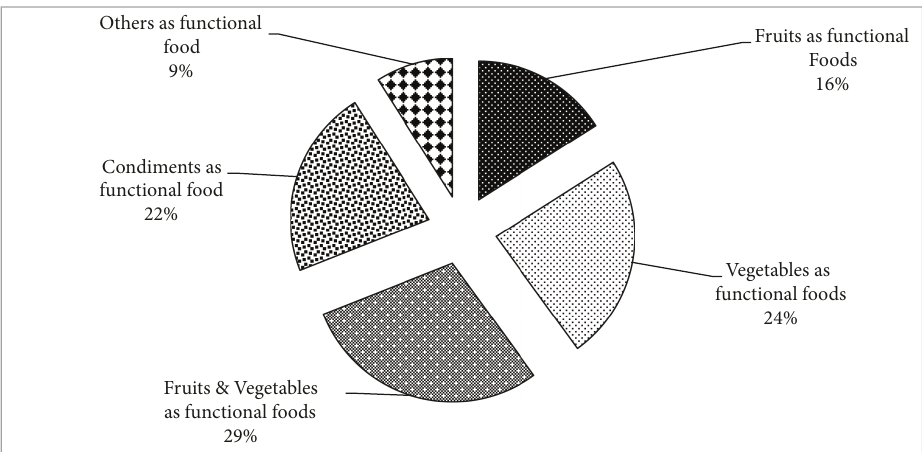
Figure 4: Sources of functional